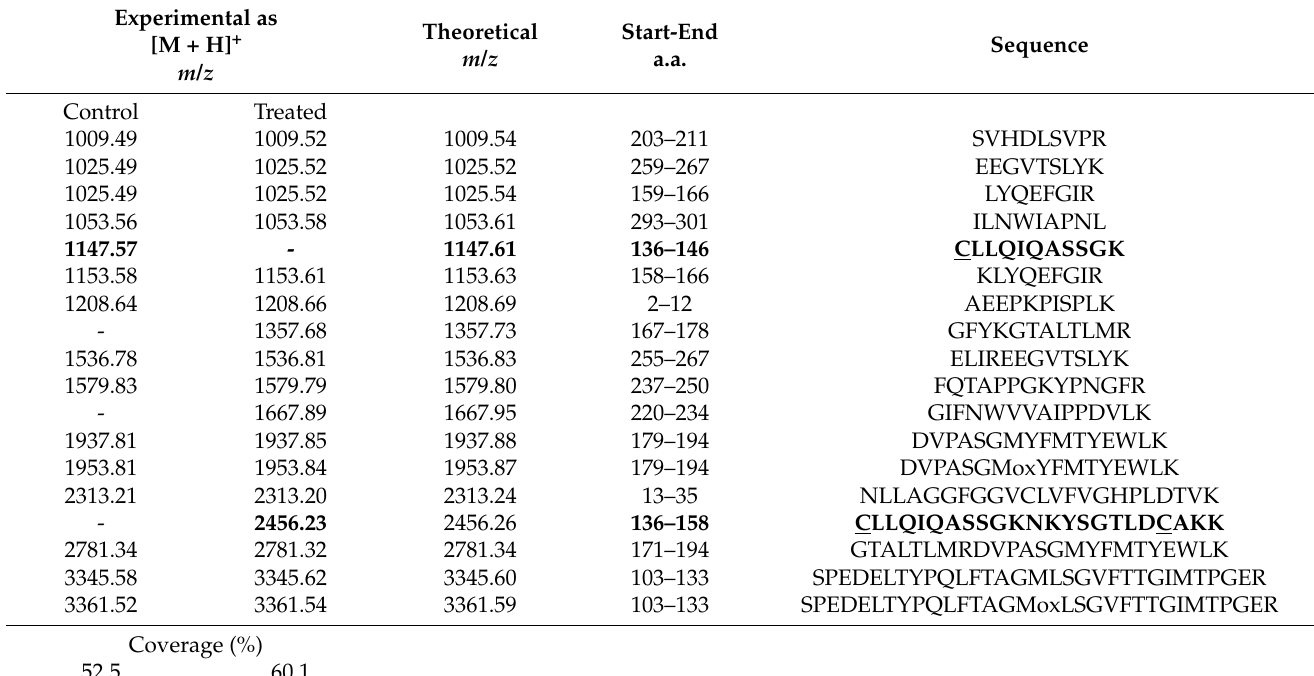
Table 1. Detectable (S/N ≥ 3) peptides after in-gel trypsin digestion of the 30 kDa band excised from the control and treated samples.